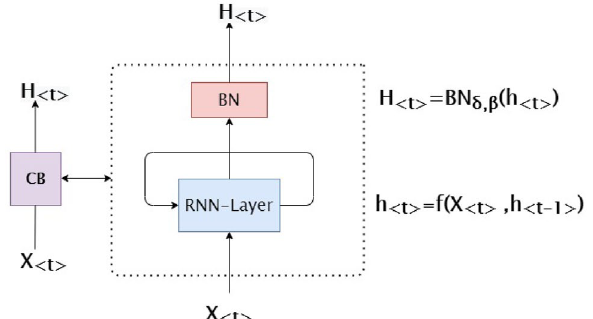
Figure 2. Composite Block (CB). The block comprises an RNN layer followed by a Batch Normalization (BN) layer. The RNN layer in the CB block has several hidden RNN cells, we identify the number of hidden RNN cells in the RNN layer as an important hyperparameter that is needed to be